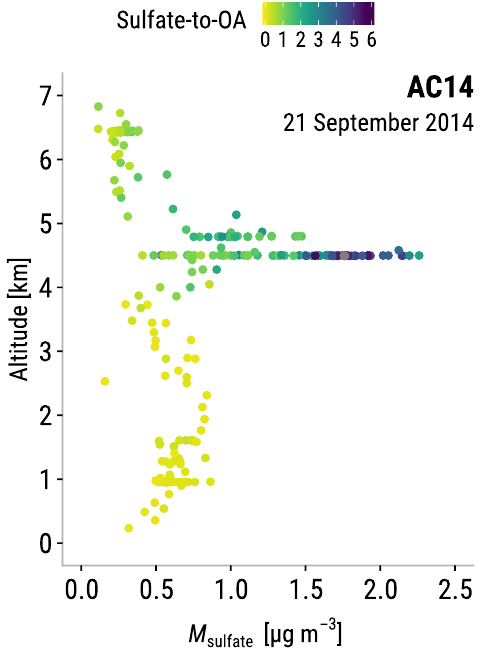
Figure 6. Sulfate layer observations over the Amazon rain forest. The figure shows the M sulfate vertical profile observed during flight AC14 (21 September 2014). Color-coded sulfate-to-OA values are truncated at a maximum of